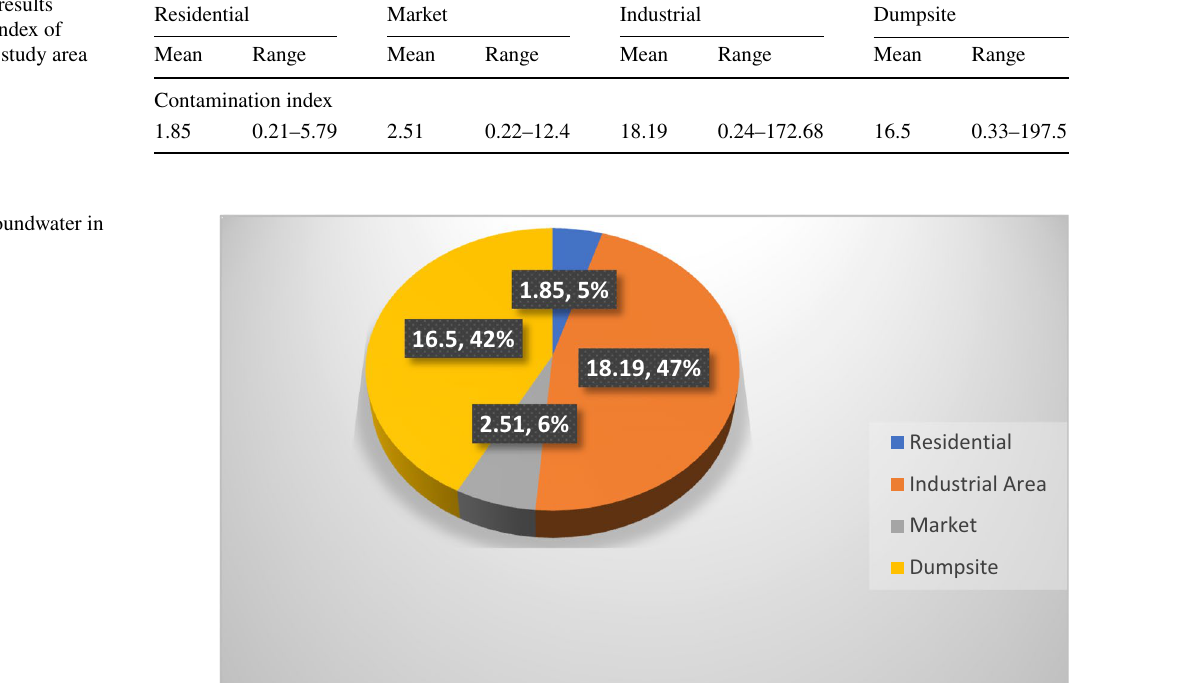
Table 4 Summary results for contamination index of groundwater in the study